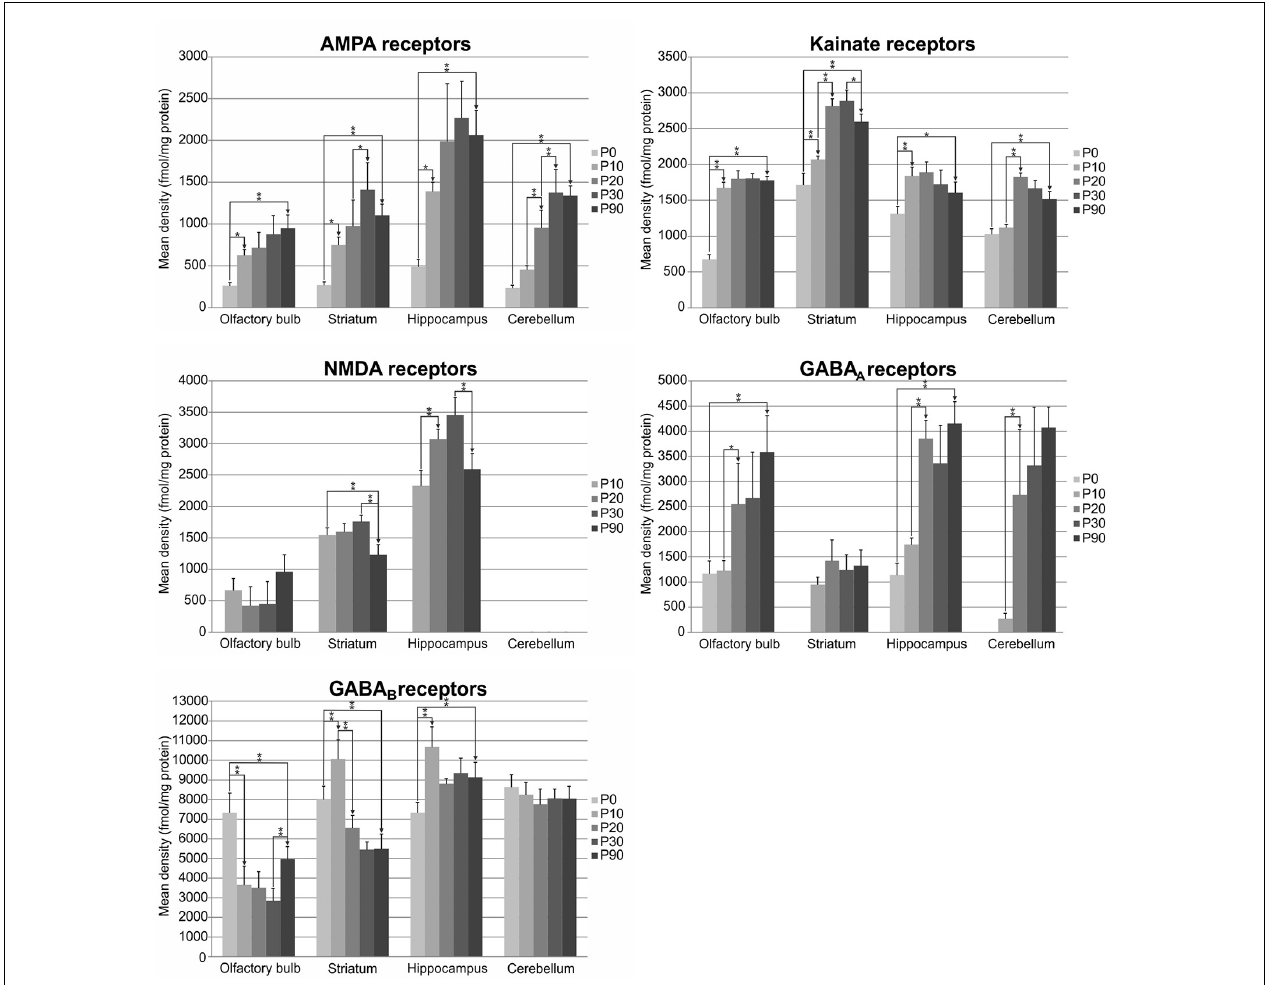
FIGURE 2 | Bar charts depicting mean (and standard deviation) glutamatergic and GABAergic receptor densities in fmol/mg protein at different developmental stages (postnatal day of Wistar rat: P0, P10, P20, P30 and P90; each age group was represented with n = 5) and different brain regions (olfactory bulb, striatum, hippocampus and cerebellum). Significant differences are indicated by asterisks ( ∗ p < 0.05 or ∗∗ p <